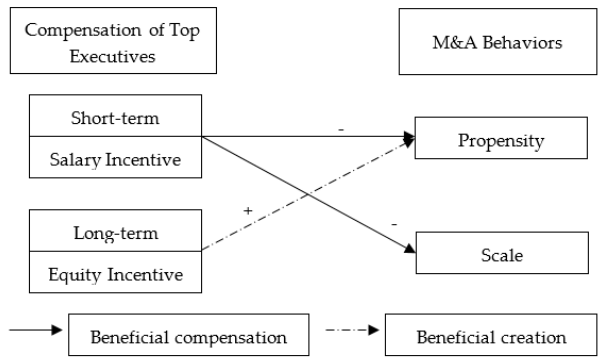
Figure 1. Compensation of Top Executives and M&A Behaviors.